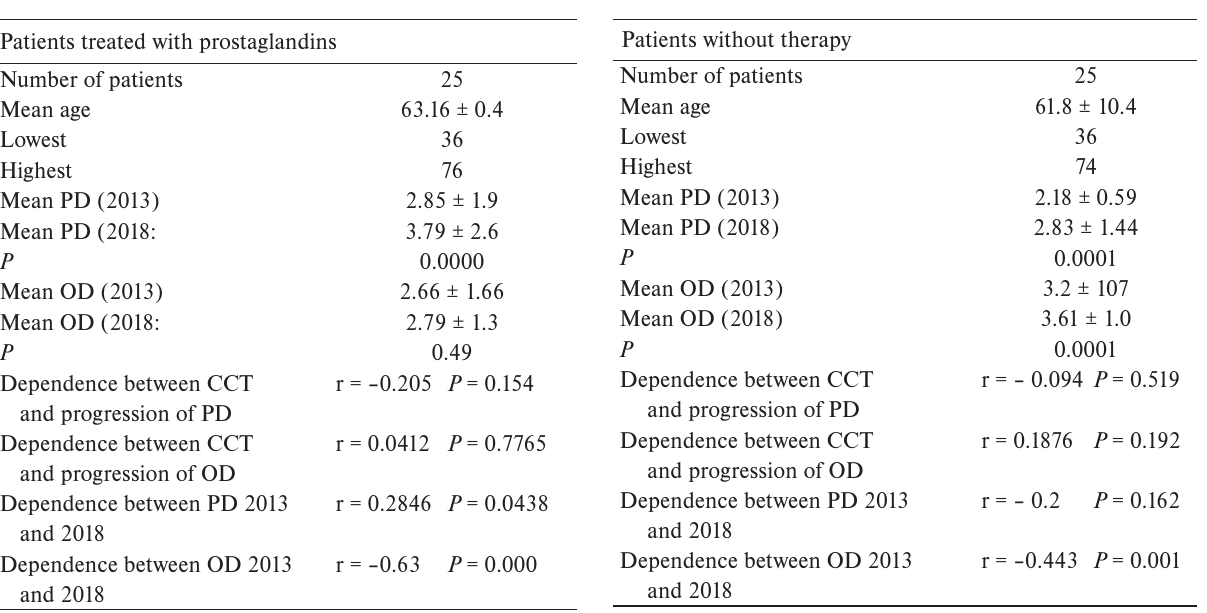
Table 2. The observed values in patients without local therapy.